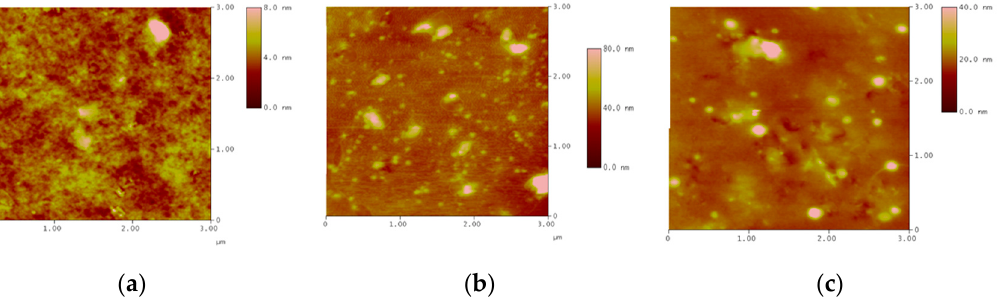
Figure 2. Inserted layer polymer contrast of different concentrations of inorganic clay mineral con- tent: ( a ) 3.85%; ( b ) 10.7%; ( c )